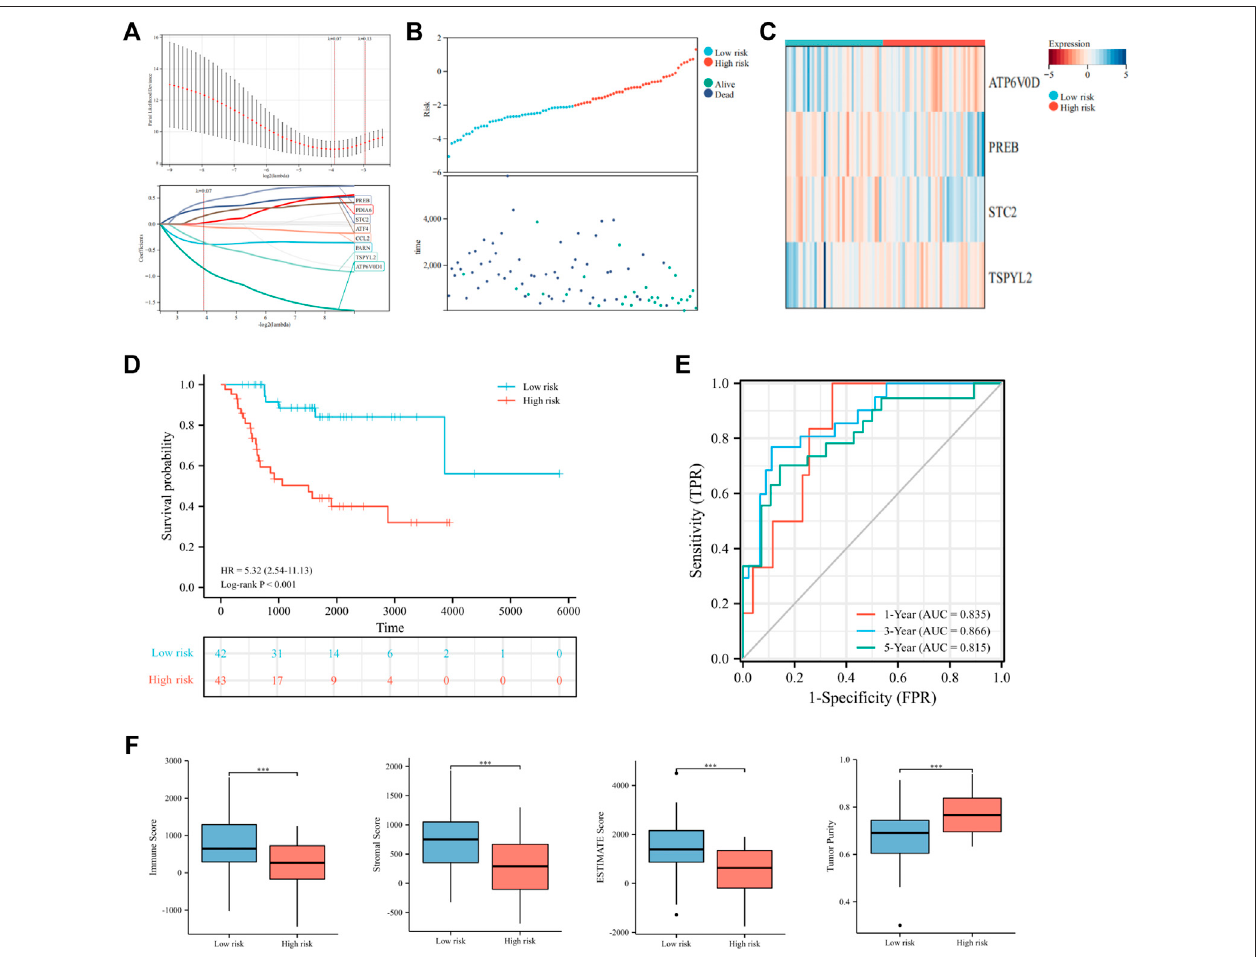
FIGURE4| ConstructionoftherisksignaturebasedonUPRRGsinthetrainingcohort. (A) EightoptimalUPRRGs fi lteredbyLASSOanalysis. (B) Distributionofrisk scores and patient status in the two risk groups; (C). Heat map showing the expressions of four candidate genes. (D) Survival curves for the two risk groups. (E) Time- dependent ROC curve of the risk model. (F) Tumor microenvironment analysis in the two risk groups through the ESTIMATE algorithm. * p < 0.05; ** p < 0.01; *** p < 0.001.